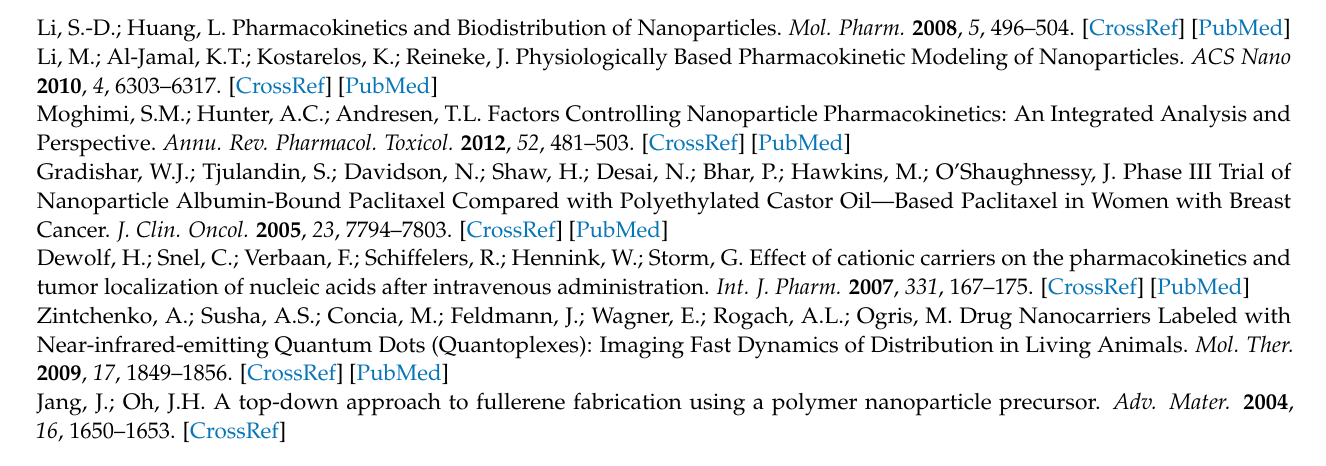
design of the double meander channel, Figure S3: UML class diagram of the control software of the syringe pumps, Figure S4: Flowchart describing the automation process of polyplex formulations, Figure S5: UML class diagram of the fraction collector’s control software, Figure S6: Flowchart describing the workflow of the fraction collector, Figure S7: Chemical structures of CO, LPO, LPOE. Table S1: Materials formulation module, Table S2: Materials control module, Table S3: Software control module, Table S4: Materials feeding module, Table S5. Materials collection module,